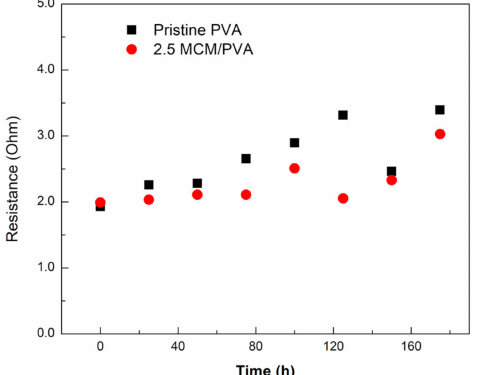
Figure 5. The resistance buildup of rechargeable ZABs having di ff erent composite membranes.